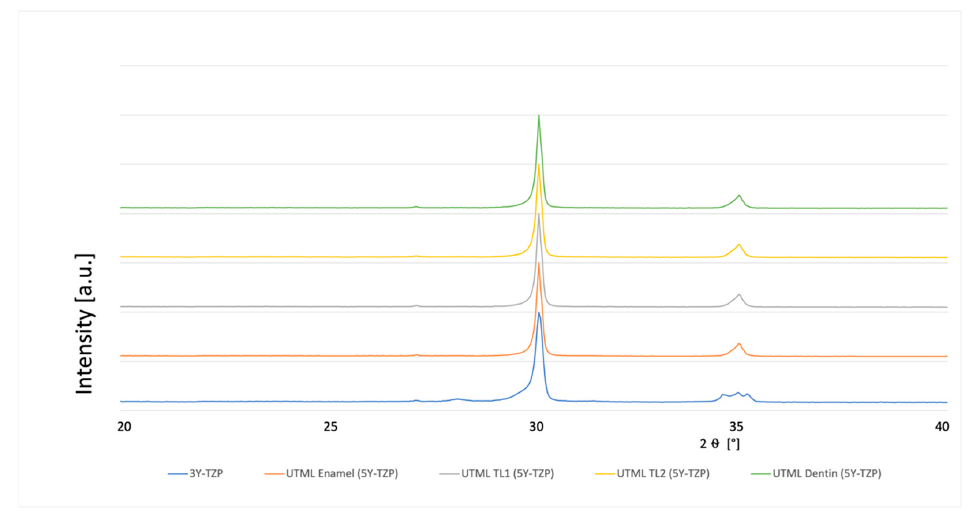
Figure 7. XRD analysis 3Y-TZP and 5Y-PSZ polished up to 1 µm and pre-sintered at cutting.